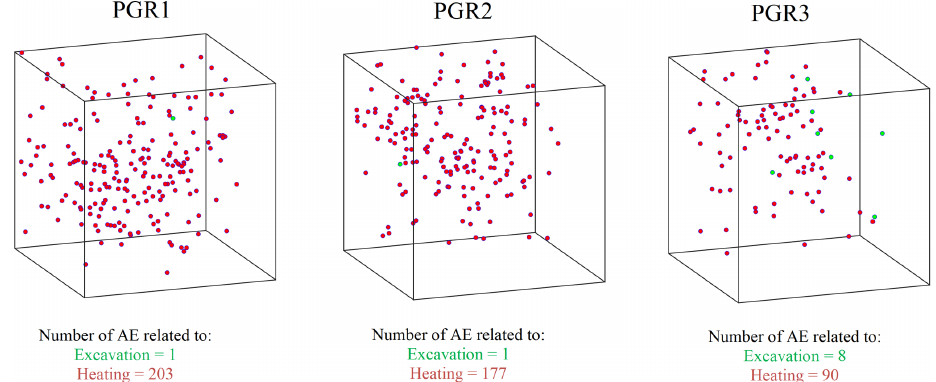
Figure 7. AE activity in PGR specimens generated in accordance with the excavation and heating stages in green and red, respectively.